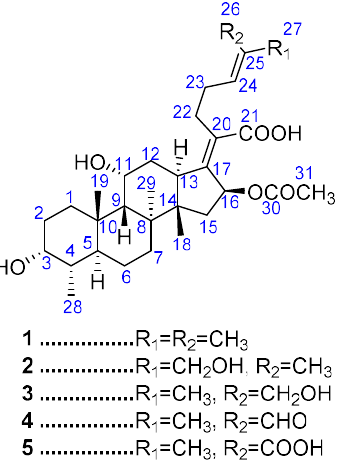
Figure 1. Structures of fusidic acid ( 1 ) and the isolated metabolites.